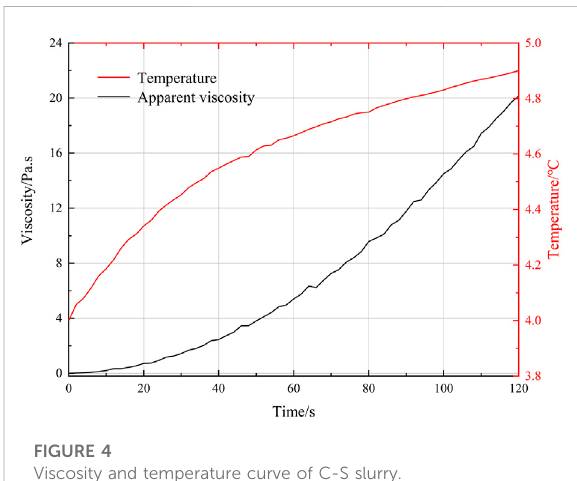
FIGURE 4 Viscosity and temperature curve of C-S slurry.